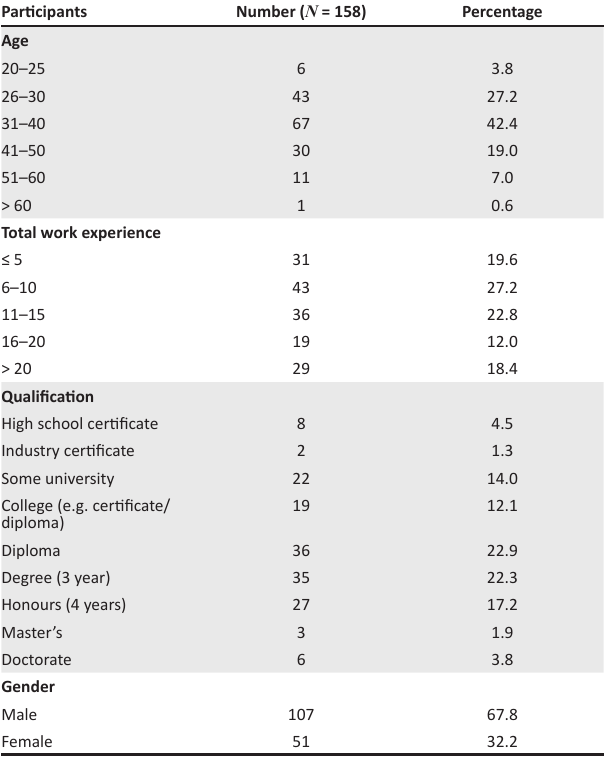
TABLE 1: Profile of the respondents. Participants